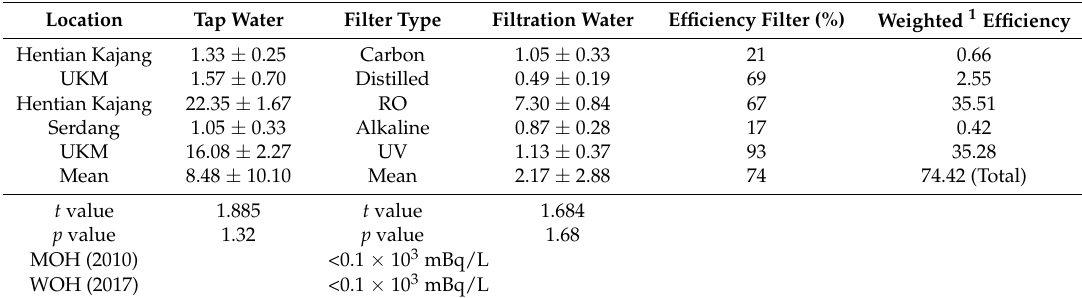
Table 8. Po-210 activity (mBq/L) in tap and filter water at Langat River Basin.